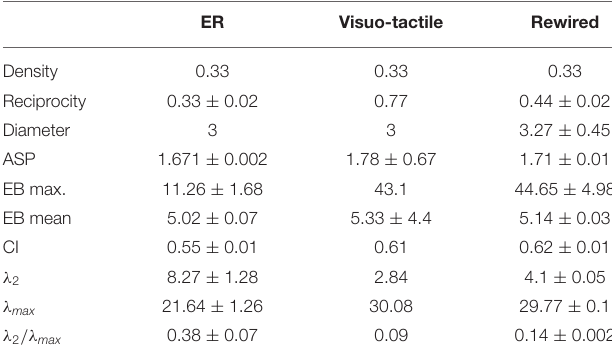
TABLE 1 | Graph metrics of the cortical visuo-tactile network and its randomized counterparts, the rewired and the Erd˝os-Rényi (ER) random